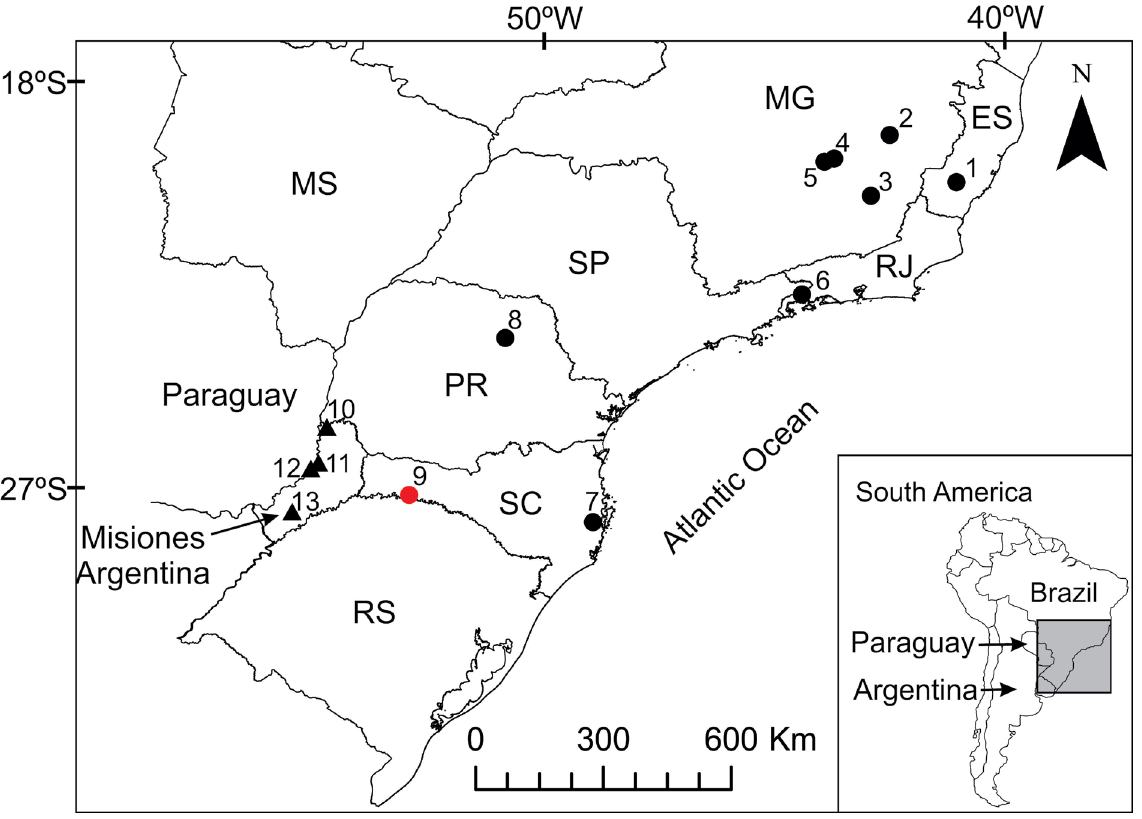
Figure 1. Map showing the collection localities of Abrawayaomys ruschii (circles) and A. chebezi (triangles), with the new record in red. Collection sites of A. ruschii modified from Passamani et al. (2011): Espírito Santo: 1. Reserva Biológica de Forno Grande (20°30’ S, 041°06’ W). Minas Gerais: 2. Parque Estadual do Rio Doce (19°30’ S, 042°31’ W); 3. Viçosa (20°47’ S, 042°55’ W); 4. Caeté (20°00’ S, 043°42’ W); 5. São Sebastião das Águas Claras (20°04’ S, 043°54’ W). Rio de Janeiro: 6. Aldeia Sapucaí (22°53’ S, 044°23’ W). Santa Catarina: 7. Santo Amaro da Imperatriz (27°41’ S, 048°46’ W); Paraná: 8. RPPN Monte Sinai, Mauá da Serra (23°47 ′ S, 050°30 ′ W) and UHE Mauá, Telêmaco Borba (23°09 ′ S, 050°42 ′ W); Santa Catarina: 9. Chapecó (27°08’S, 052°42’W). Localities of A. chebezi based on Pardinãs et al . (2009): Misiones, Argentina: 10. Conjunction arroyo Mbocai and route 12 (25°40 ′ S, 054°30 ′ W, type locality); 11. Eldorado (26°24 ′ S, 54°31 W); 12. Montecarlo (26°34 ′ S, 54°44 ′ W); 13. Campo Ramón (27°25 ′ S, 055°1 ′